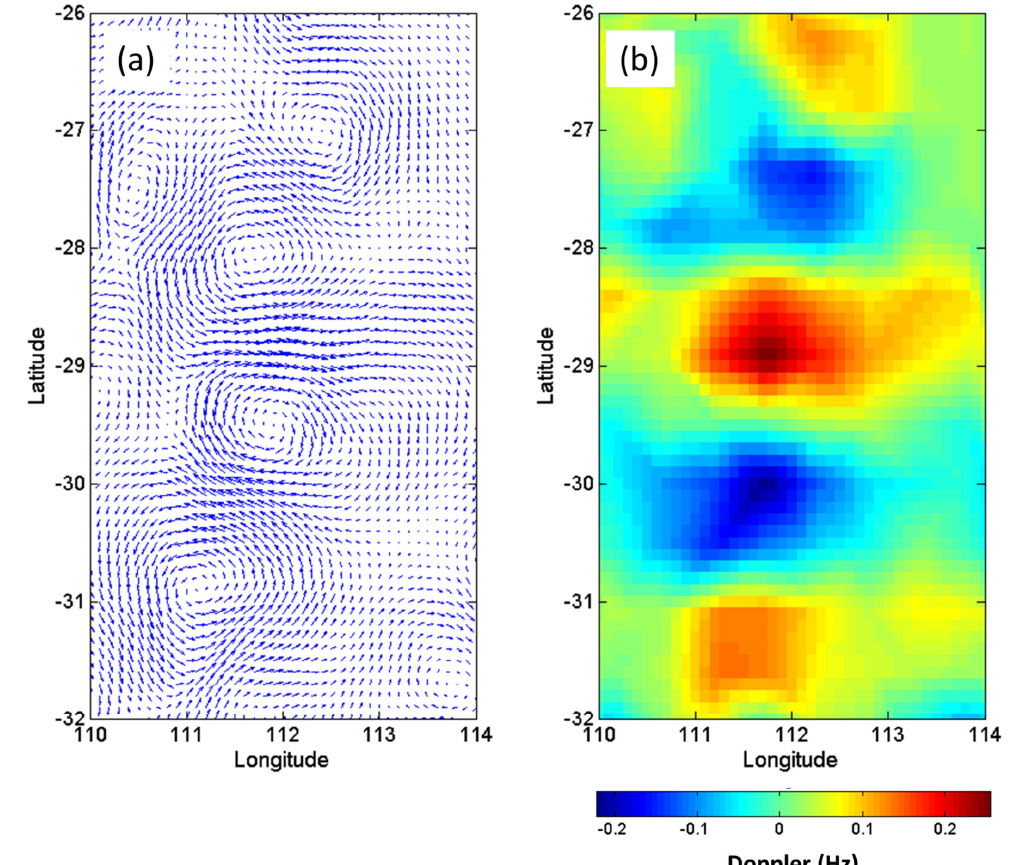
Figure 36. ( a ) The synthesised current field within the rectangle shown in Figure 35, sampled at a higher resolution than shown there. ( b ) The corresponding radial current speed map as it appears to a single radar.